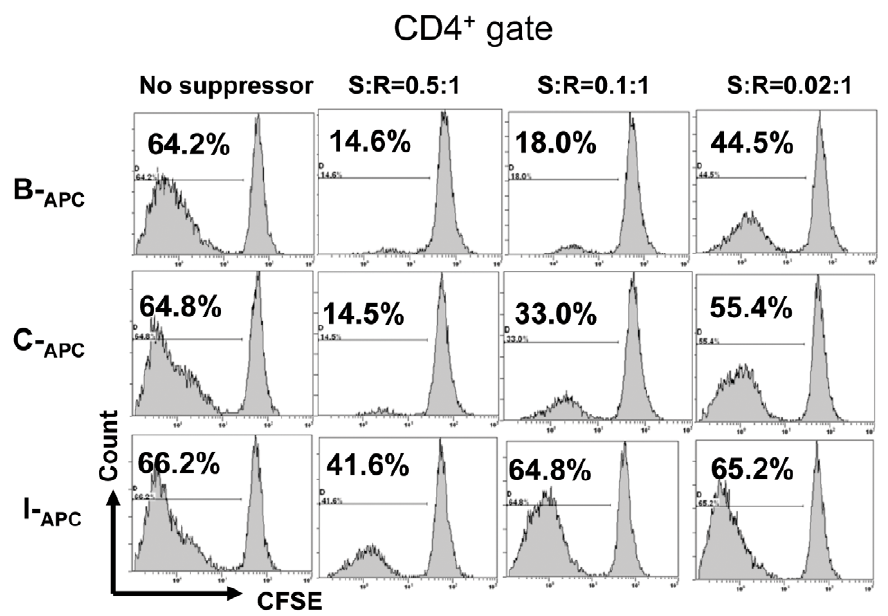
Figure 3. Suppression by the invitro expanded CD8 + CD28 2 T cells is restricted by donor HLA class I antigens. Suppression assays were set up as described in Figure 2, with the exception that the stimulator APCs for CD4 + proliferation were from either the priming donor (B- APC ), an indifferent donor (I- APC , HLA-A, B and DR fully mismatched with donor B), or a partially matched donor (C- APC , who shared identical HLA class I, but not class II antigens, with donor B). Proliferation of the CD4 + cells was measured by CFSE dilution. Data shown are representative of three